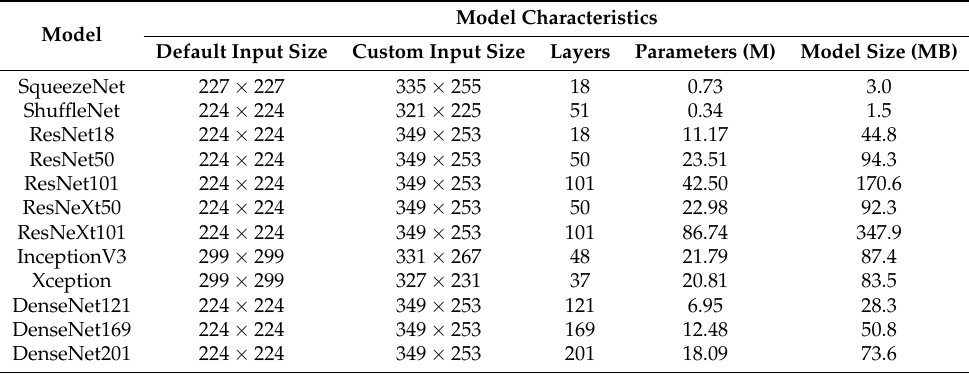
Table 1. Characteristics of the deep CNN architectures considered for this